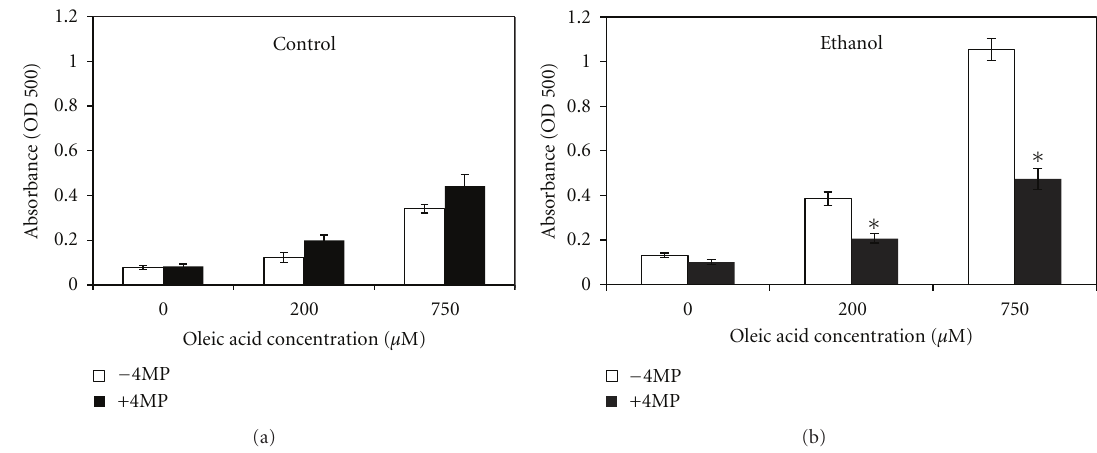
Figure 4: Ethanol and oleic acid induced fat accumulation requires ethanol metabolism. Oil Red O staining after 48 hours in the presence of increasing concentrations of oleic acid either with or without the addition of 0.25mM 4-methylpyrazole (4MP) to inhibit ethanol metabolism. Results were from the ORO-based detection of neutral lipids in (a) oleate alone-treated (control) cells and (b) WIF-B cultures treated with both oleic acid and 25mM ethanol. Values are means ± SEM ( N = 4). ∗ Significantly di ff erent ( P < 0 . 05) from control